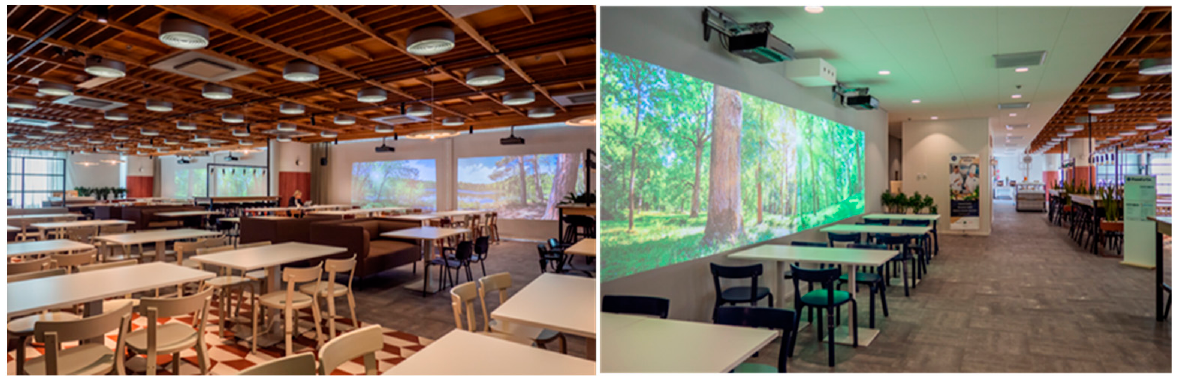
Figure 3. Illustration of ‘nature ambience’ projections in different parts of the lunch restaurant.